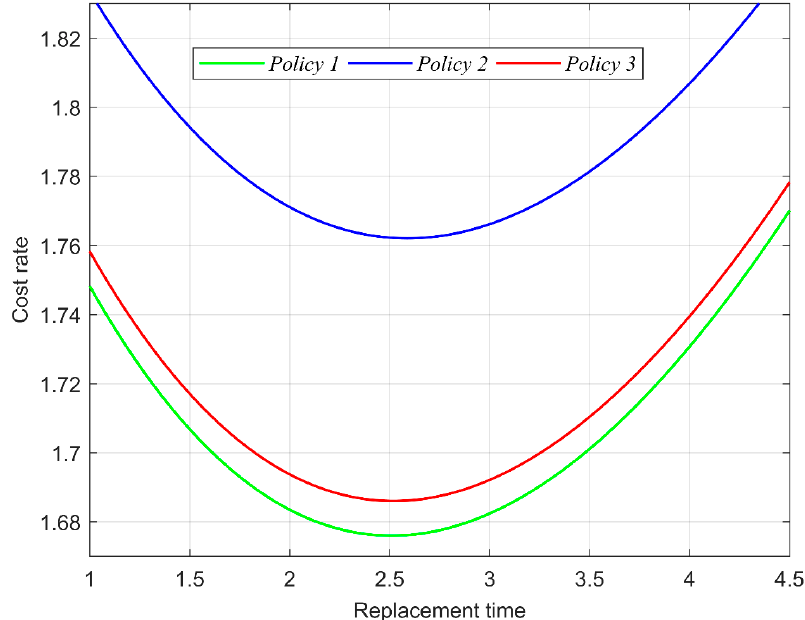
Figure 7. The post-warranty maintenance policies.